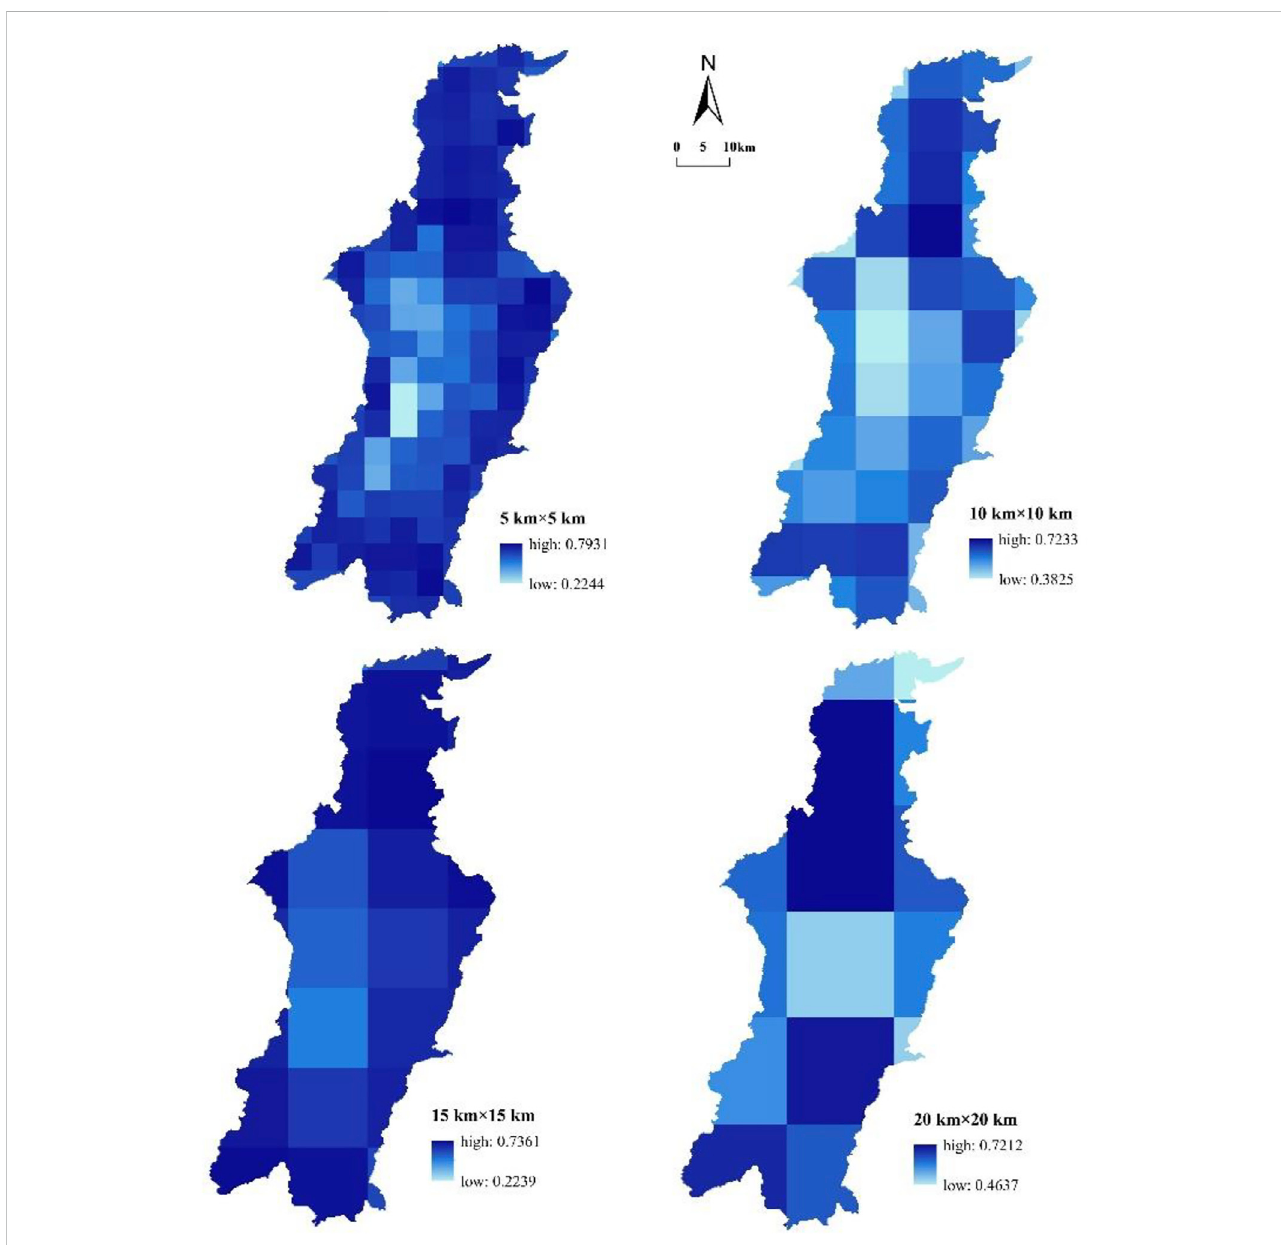
FIGURE 3 Ecosystem health in Dianchi Lake basin at four quadrat